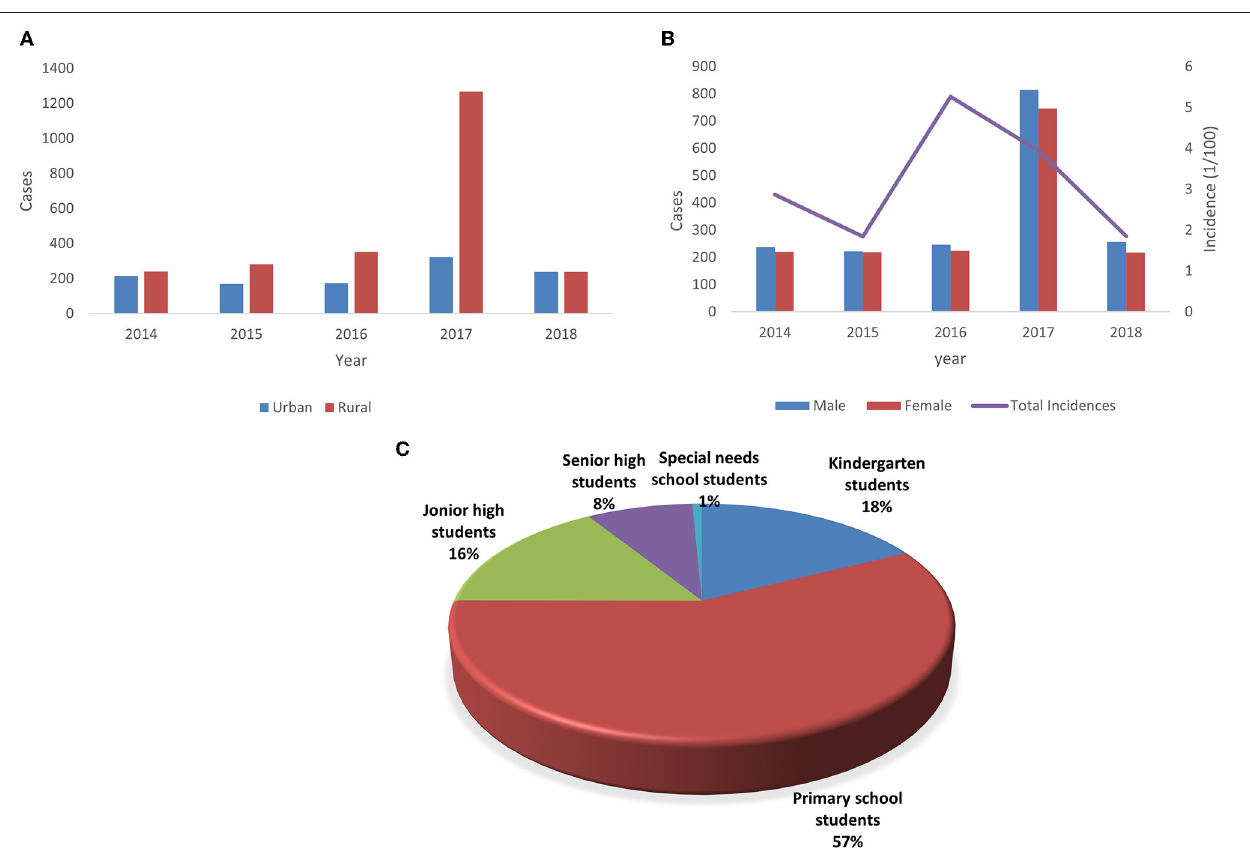
FIGURE 2 | Demographic characteristics of influenza cases in Chongqing from 2014 to 2018. (A) Annual amount of influenza cases by gender and the annual incidence of total influenza cases. (B) Annual amount of influenza cases by region. (C) Distribution of influenza cases by educational